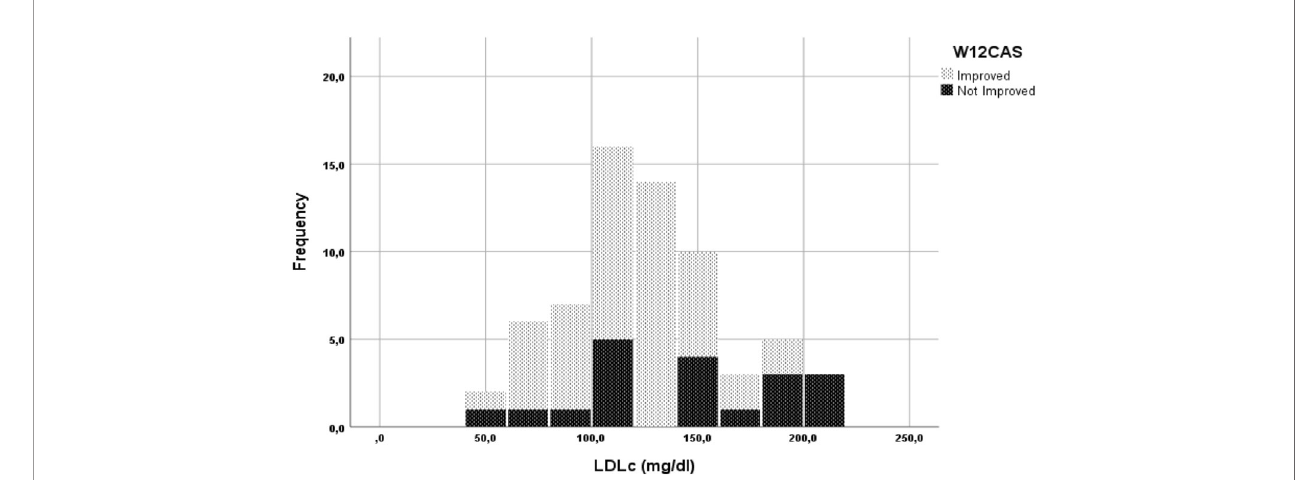
FIGURE 1 | Stacked histogram of low-density lipoproteins cholesterol (LDLc) levels grouped for W12CAS